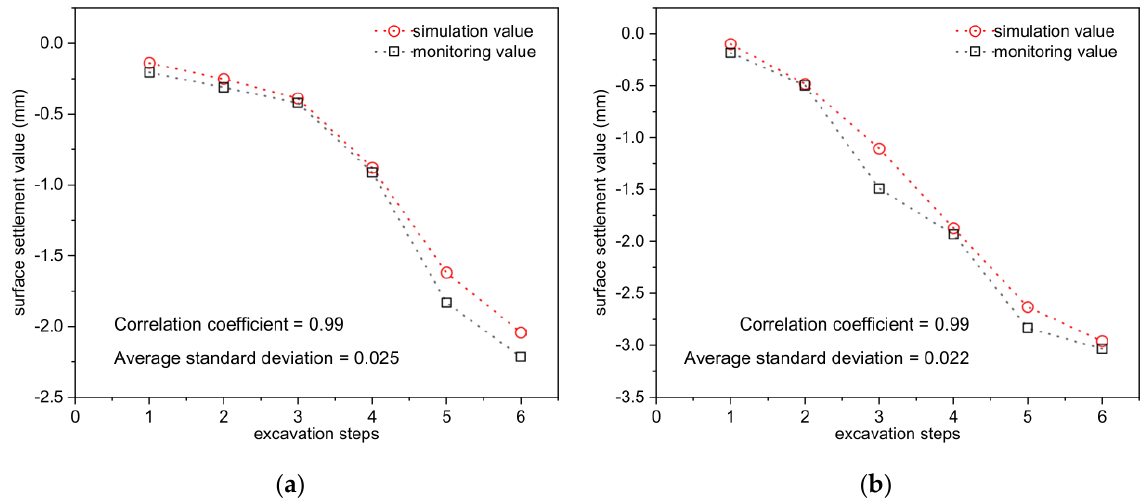
Figure 11. Comparison of surface settlement values of key monitoring points. ( a ) key point 1; ( b ) key point 2.